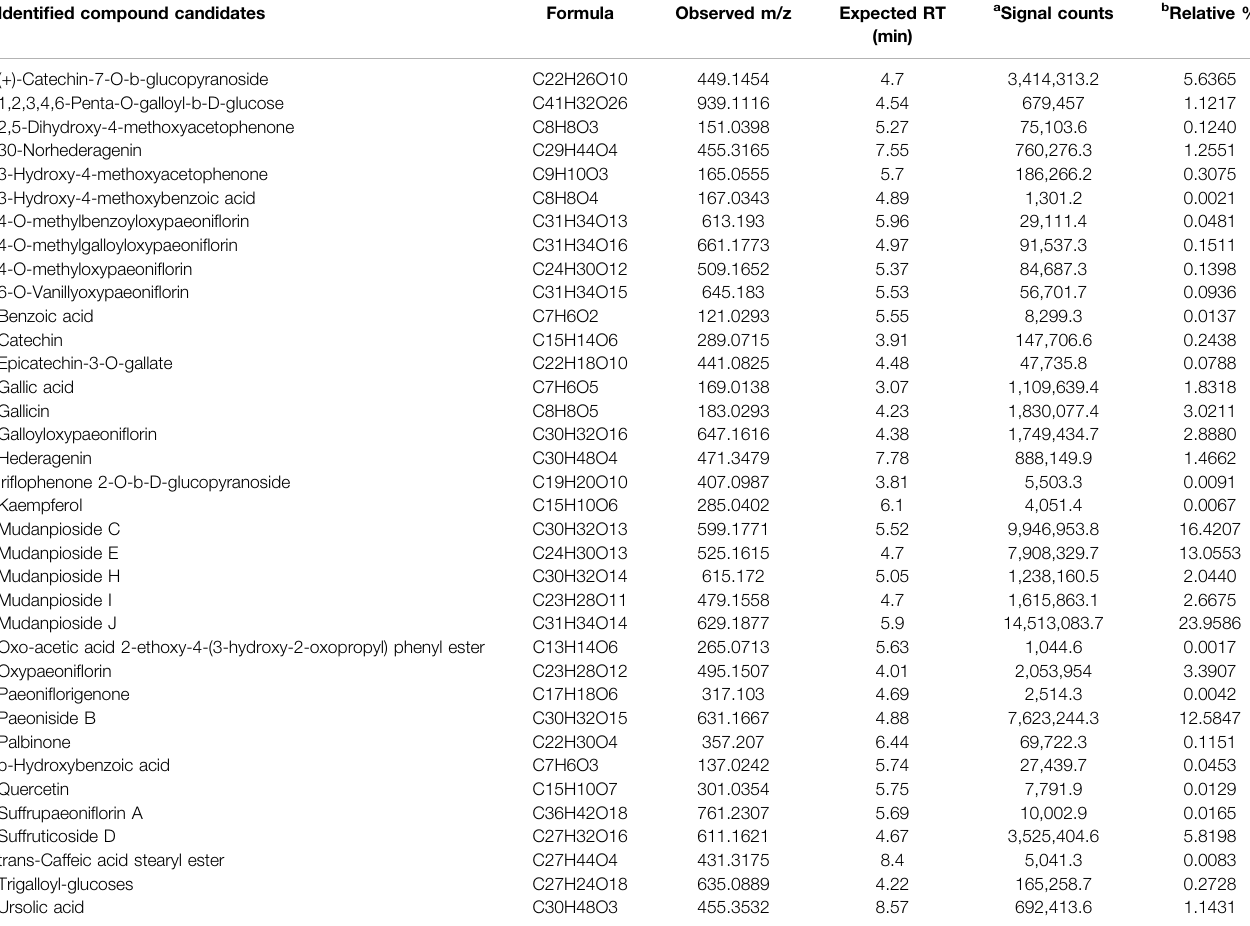
TABLE 1 | Identi fi ed compound candidates in MDP5. Identi fi ed compound